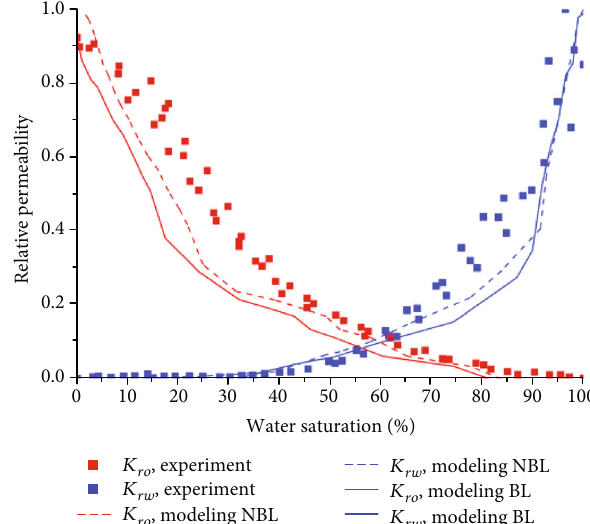
Figure 3: Predicted relative permeability of Berea sandstone (lines) compared to the experimental data by Oak [52] (square). The oil relative permeability data are marked with red, while the water relative permeability data are marked with blue. Data modeling NBL/BL means that the calculations using the model without/with BL consideration,